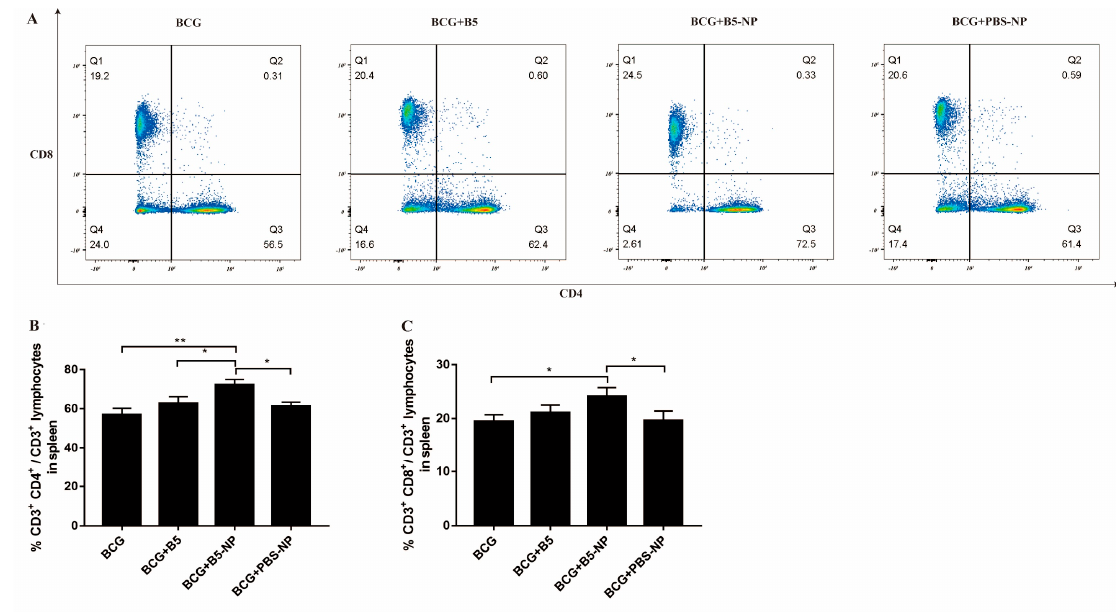
Figure 5. The percentage of CD3 + CD4 + and CD3 + CD8 + lymphocytes within splenocytes. ( A – C ) Flow cytometry analysis percentage of CD3 + CD4 + and CD3 + CD8 + lymphocytes within splenocytes. At week 13, isolated spleen cells from mice were stained with PerCP-Cy5.5-conjugated anti-CD3, FITC-conjugated anti-CD4, APC-conjugated anti-CD8. CD3 + CD4 + and CD3 + CD8 + T-cell subgroup were detected via flow cytometry. Data collected are expressed as the mean ± SD of three independent experiments (* p < 0.05; ** p <